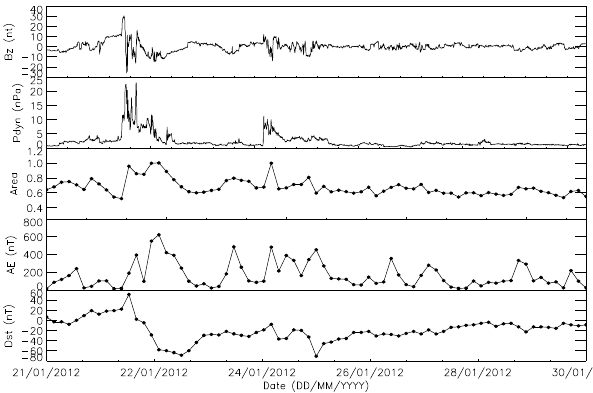
Figure 9. Same as Fig. 7 except during 21–30 January